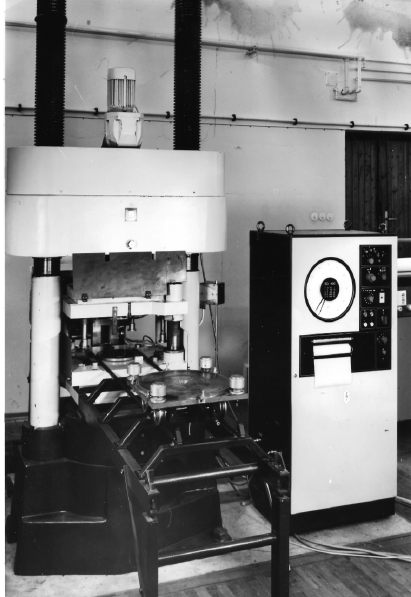
Figure 13. New 400 t press.